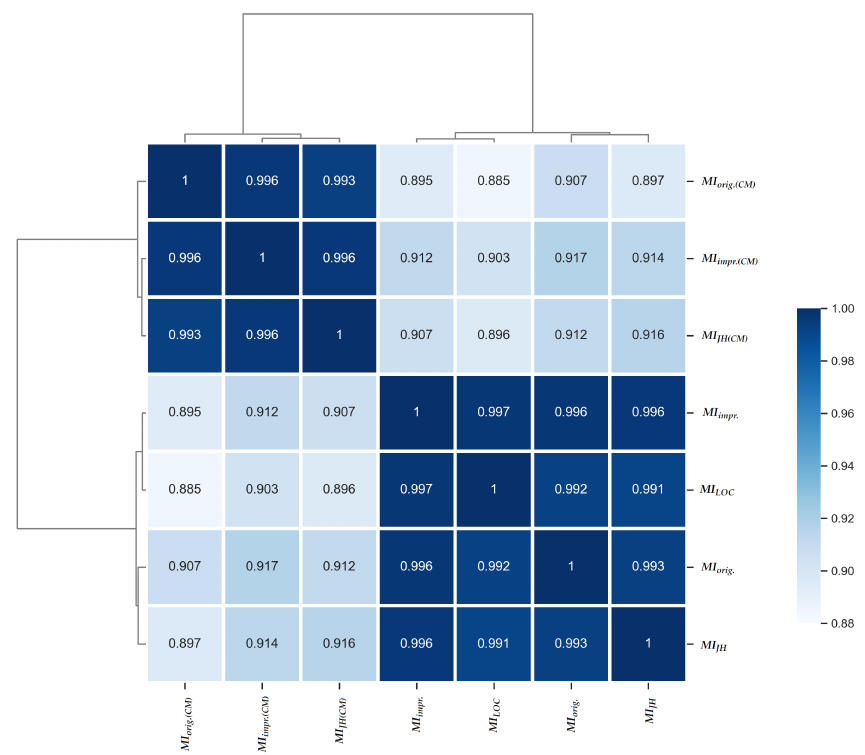
Figure 7. Correlation heat map and dendrogram of hierarchical agglomerative